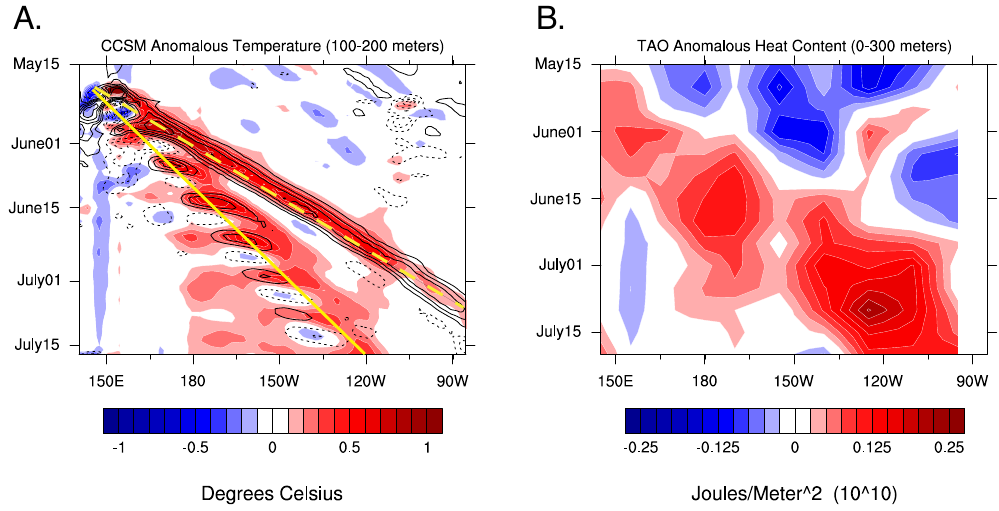
Fig. 3. (A) Longitude-time plot of the anomalous temperature and zonal velocity shown in Fig. 2 averaged between 0 and +5 ◦ N. The yellow dashed line denotes the Kelvin wave velocity. The solid yellow line is the Yanai wave group velocity for the first baroclinic mode scaled by the Kelvin wave speed. The estimated modeled Kelvin and Yanai wave speeds are ∼ 3.1 and ∼ 2.3ms − 1 , respectively. (B) Longitude-time plot of observed, anomalous upper ocean heat content (compared to climatology) from the TAO buoy array. Ocean heat content is averaged between − 2 and +2 ◦ N, and integrated to 300m depth. The time interval is 15 May–15 July 2003, corresponding to the same modeled interval shown in Fig. 3a. The estimated observed Kelvin wave speed is ∼ 2.9ms − 1 . Both the modeled and observed Kelvin wave speeds are within the range of documented wave observations from the TAO array (Shinoda et al.,